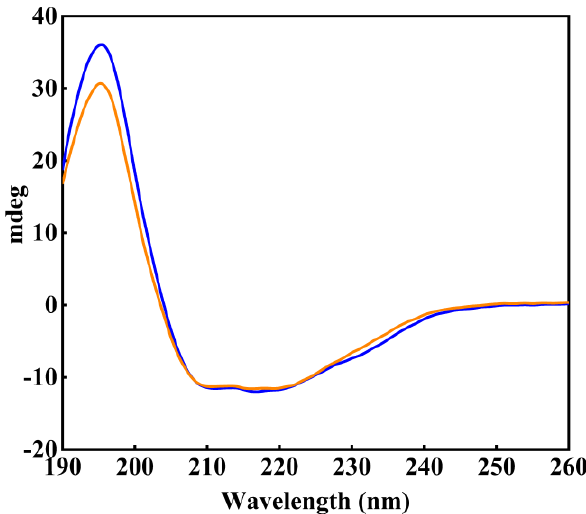
Figure 3. Far − UV CD spectra of arylesterase LggEst wild type and the deleted mutant. CD spectra were recorded from 190 to 260 nm. The spectra of wild type and the deleted mutant are shown in blue and orange, respectively. Protein concentration of 0.1 mg mL − 1 was used for the analysis.